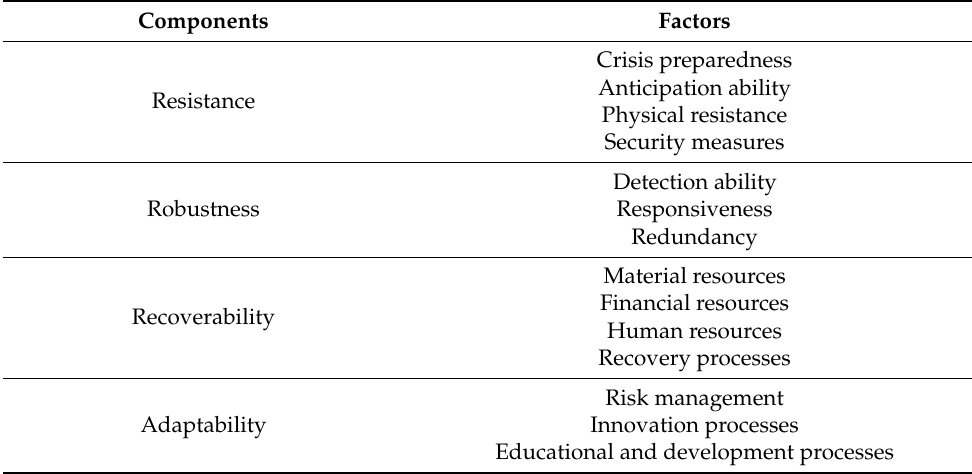
Table 1. Factors determining resilience of critical infrastructure elements.